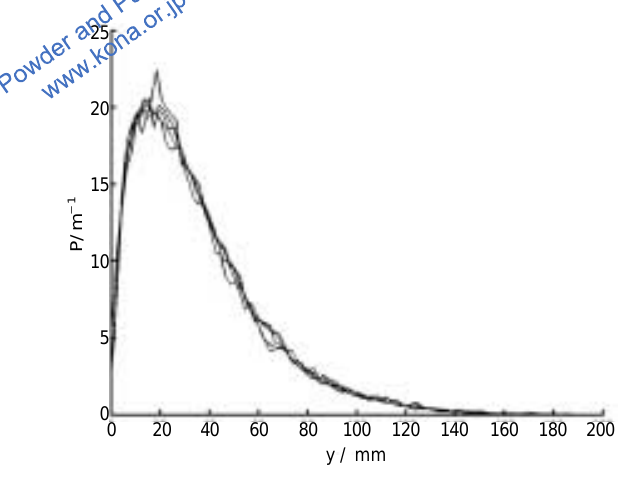
A comparison of the long-time displacement probability curves for a range of grain start heights (y (cid:4) 2.5, 7.5, 12.5, 17.5 and 22.5 mm). This indicates that the long-time steady state behaviour of the system is broadly indepen- dent of the start location and suggests that an assumption of ergodicity is likely to be appropriate.